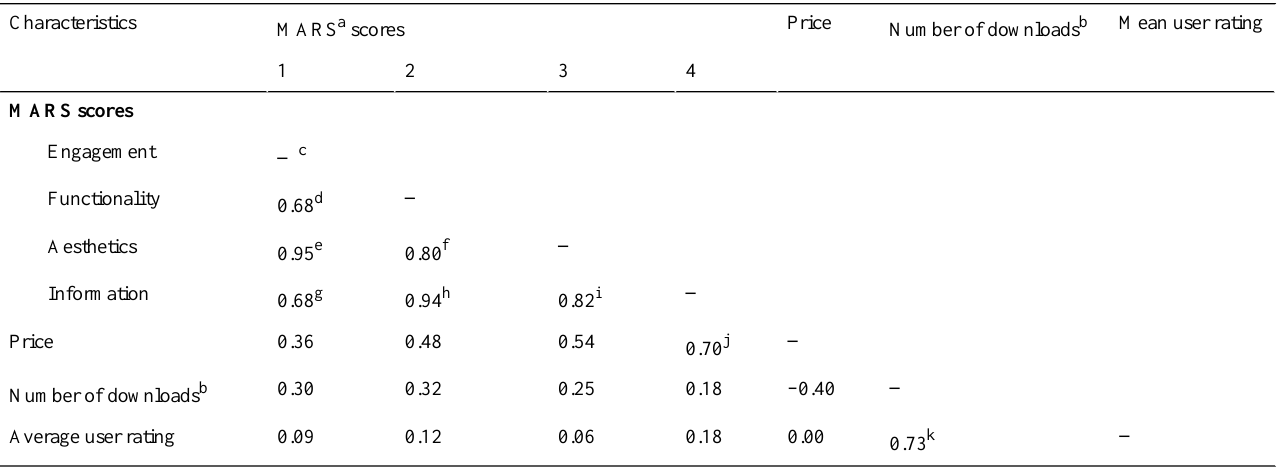
Table 2. Correlation matrix among MARS scores, price, number of downloads, and average user